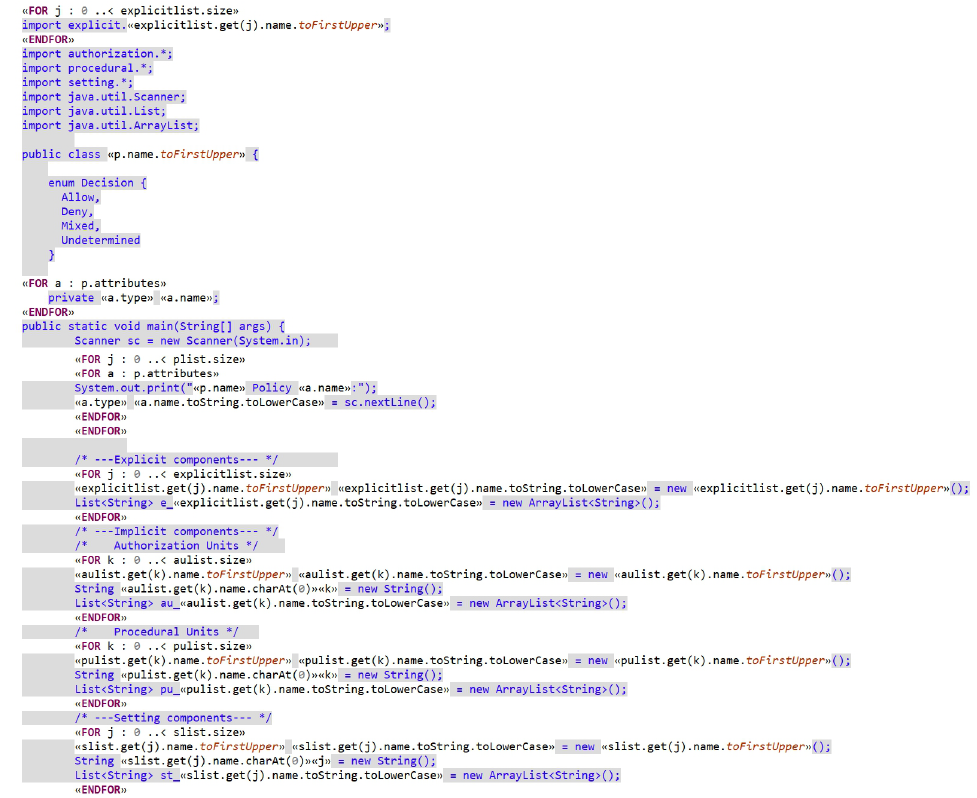
Figure 22. A sample of Eclipse Xtend